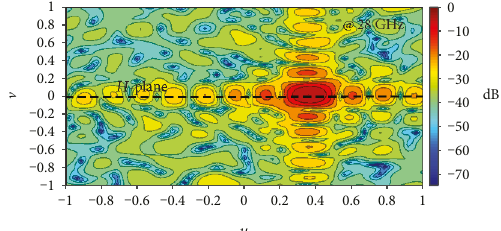
Figure 11: Synthesized 28 GHz pattern of the 15 × 15 o ff set-fed re fl ectarray.